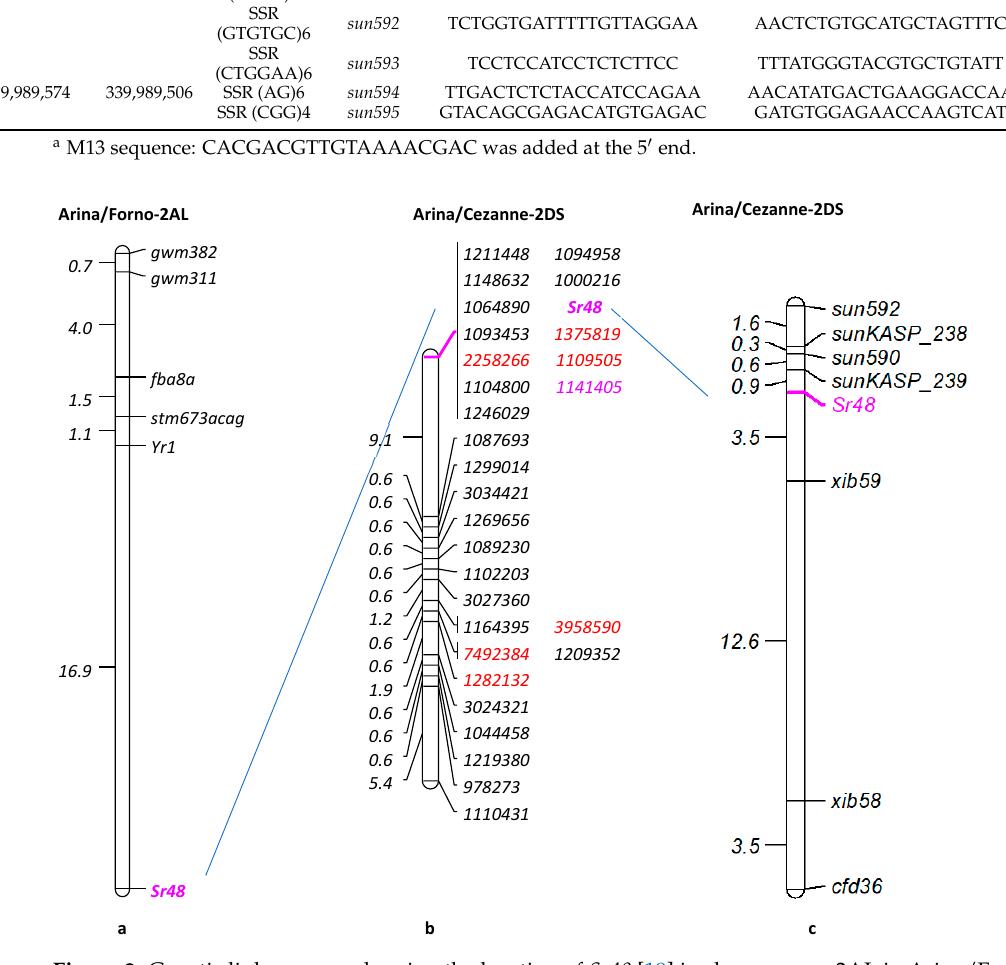
Figure 2. Genetic linkage map showing the location of Sr48 [19] in chromosome 2AL in Arina/Forno ( a ), the DArTSeq marker map of 2DS on 92 Arina/Cezanne RILs ( b ) and PCR-based marker 2DS map of 172 Arina/Cezanne RILs ( c ). Table 2. Kompetitive Allele-Specific polymerase chain reaction (KASP) markers, designed for single-nucleotide polymorphisms (SNPs) and detected in sequenced parental sequence-tagged site (STS)